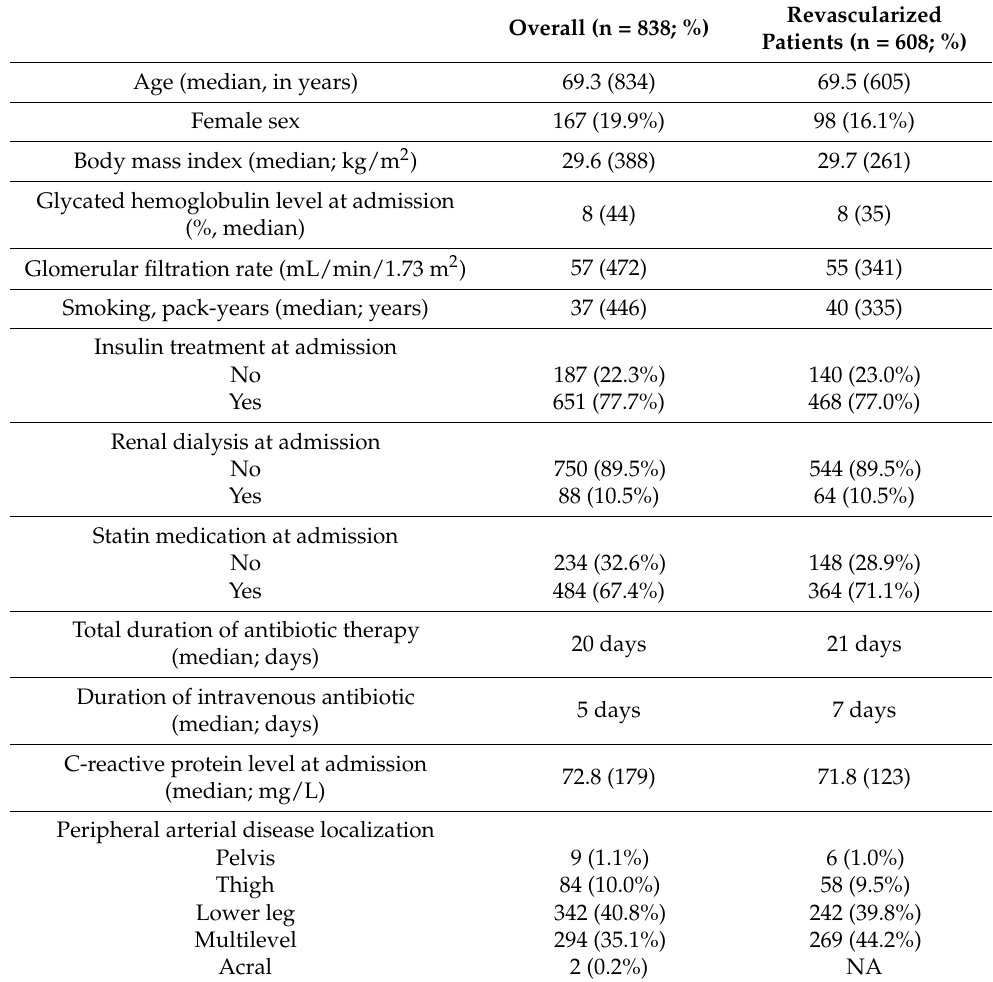
Table 1. Characteristics of the included patients with diabetic foot